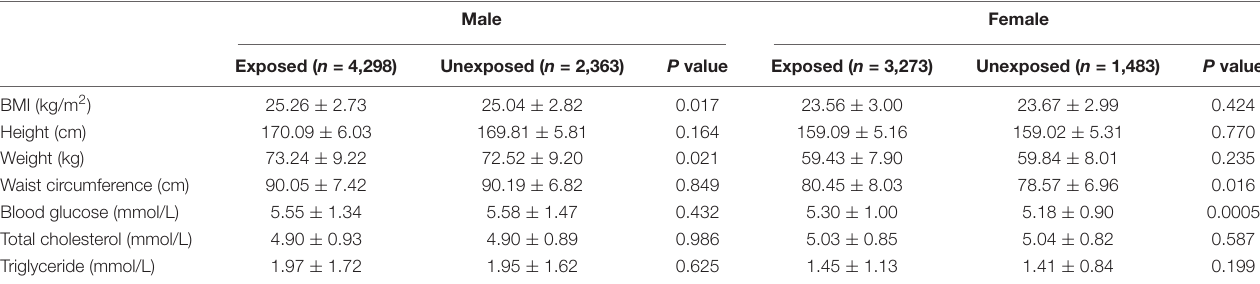
TABLE 2 | Physiological and biochemical values for Set 2 ( t -test).